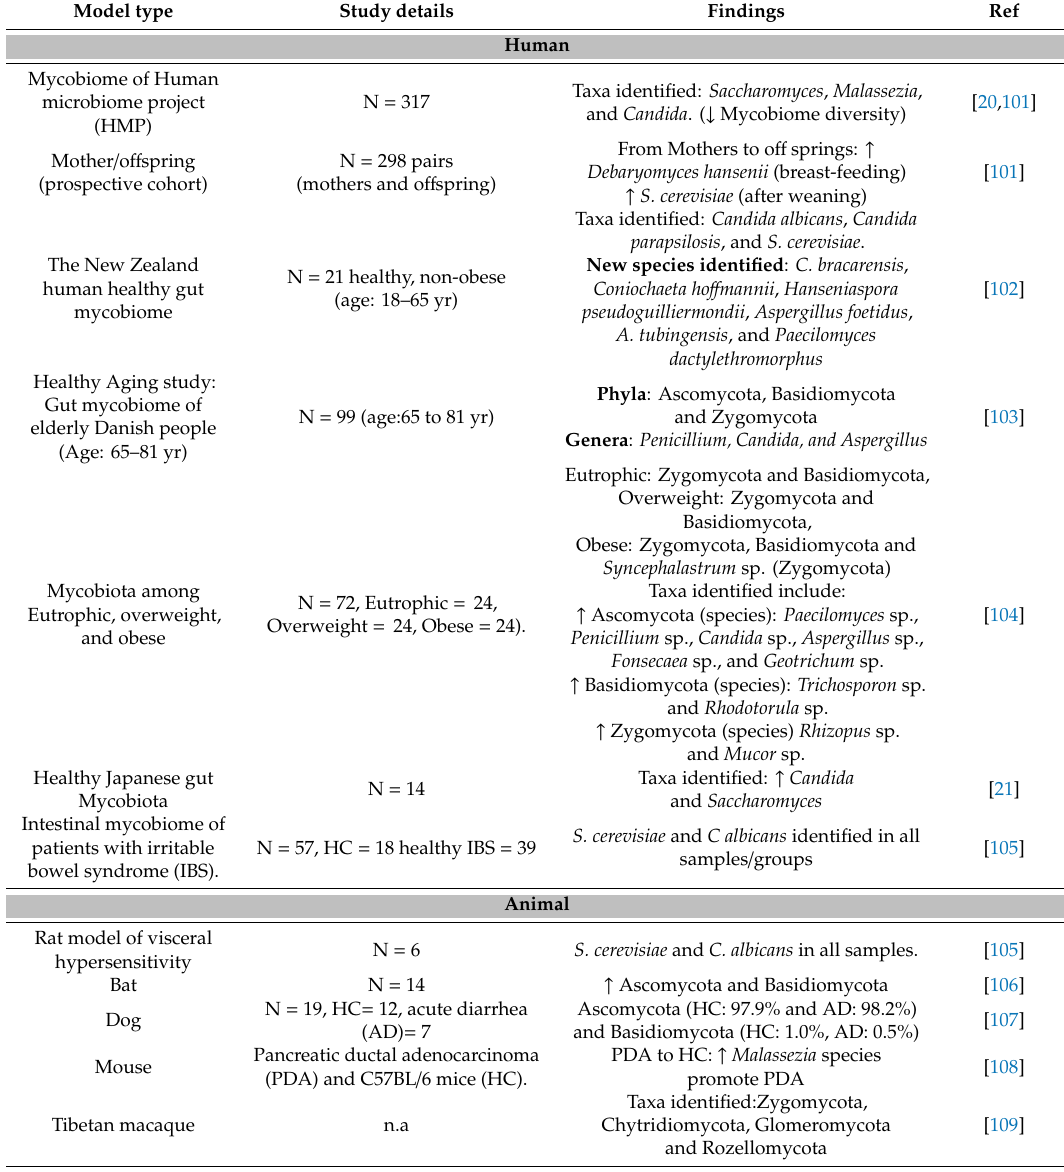
Table 5. Summary of significant studies and their findings on the gut